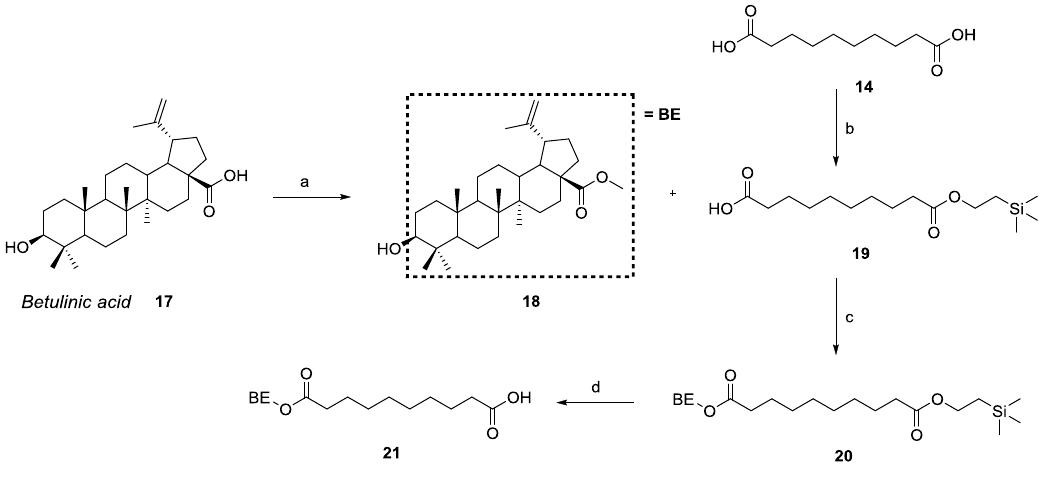
Figure 3. Chemical structure of target betulinic-trehalose conjugates 3-Be-mono and 4-Be-bis , of key synthetic intermediate hexaTMS-protected trehalose 5 and carboxylated betulinic-linker adduct 21 . The synthesis of key intermediate 21 is reported in Scheme 4.